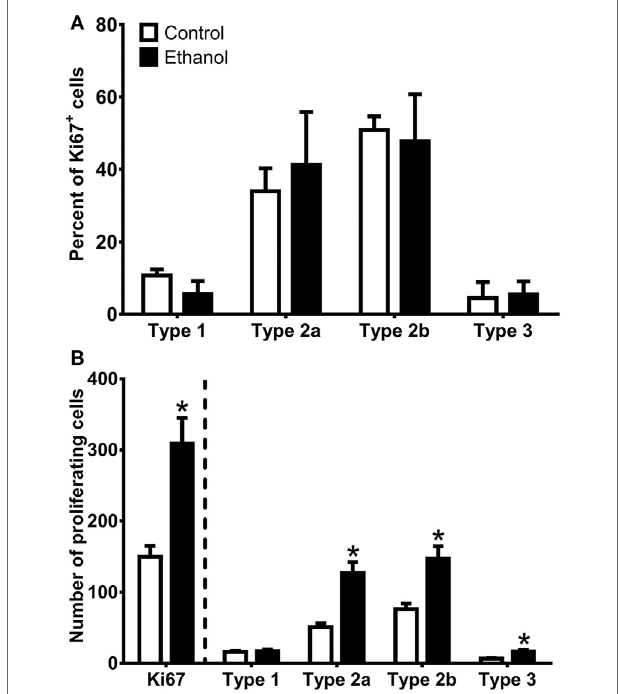
FigUre 5 | Quantification of progenitor cell subtypes at day 7 of abstinence. (a) The graph shows the proportion of sampled Ki67 + cells that were type 1 (GFAP + /Sox2 + /NeuroD1 − ), type 2a (GFAP − /Sox2 + /NeuroD1 − ), type 2b (GFAP − /Sox2 + /NeuroD1 + ), and type 3 (GFAP − /Sox2 − /NeuroD1 + ). (B) The graph shows calculated NPC subtypes based on the number of Ki67 + cells present in the SGZ multiplied by the NPC subtype proportions. * indicates p <